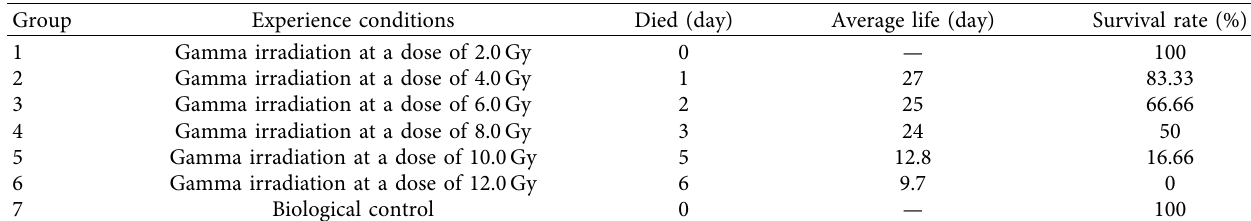
Table 2: Survival rate of rabbits subjected to external c